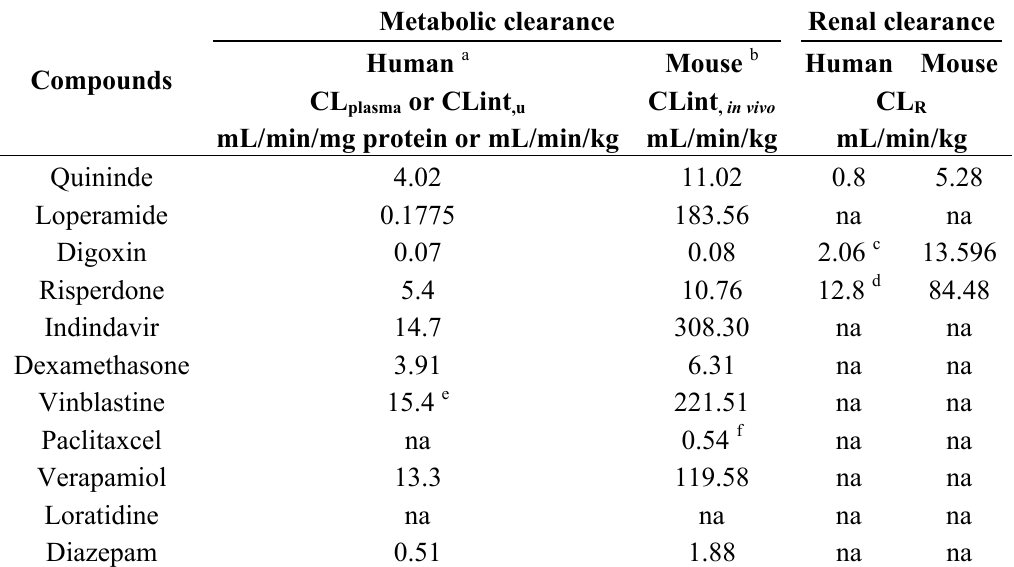
Table S3. Mouse PBPK metabolic and renal clearance